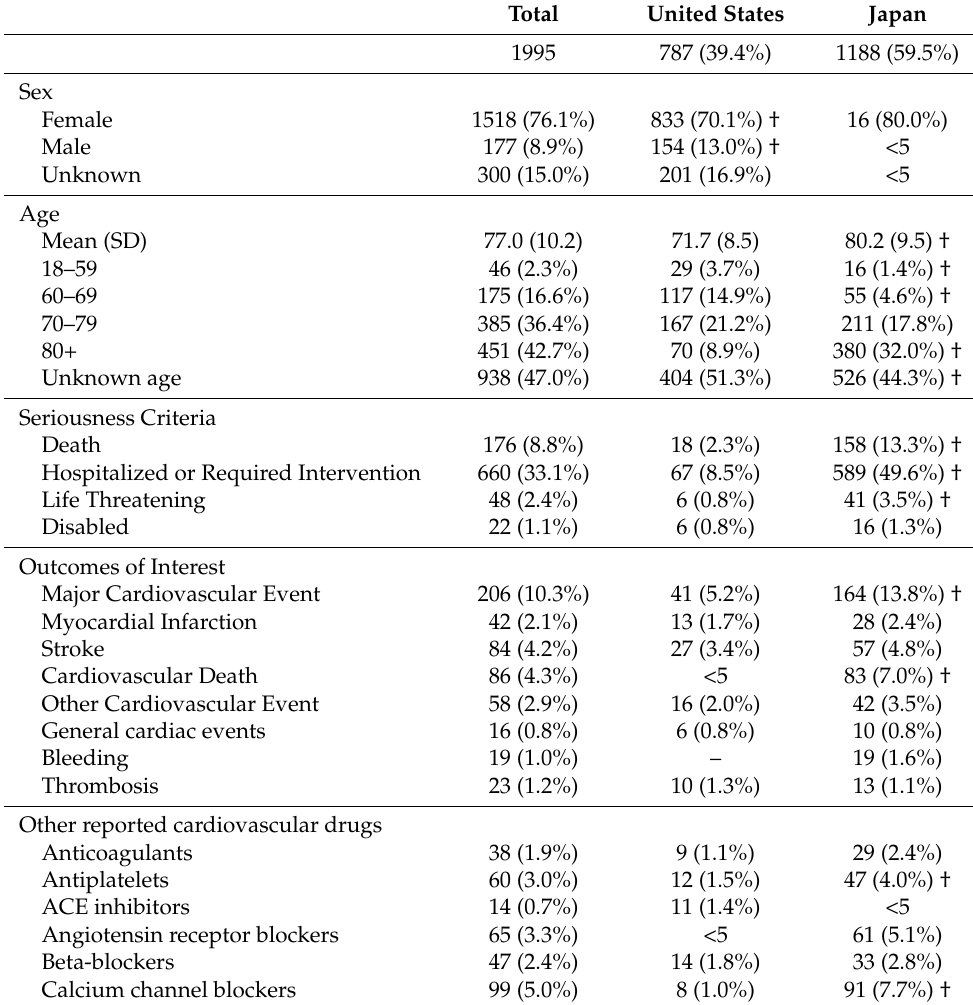
Table 1. Demographic characteristics of individual case safety reports with romosozumab, overall ( N = 1995), and stratified by region of report (the United States, N = 787) and Japan ( N = 1188). Total United